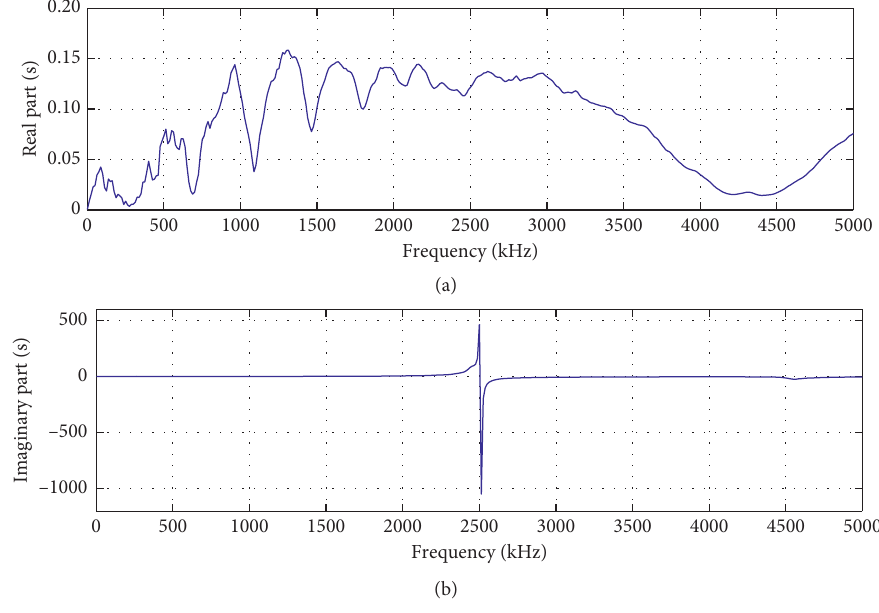
Figure 13: Admittance characteristics for column #1.